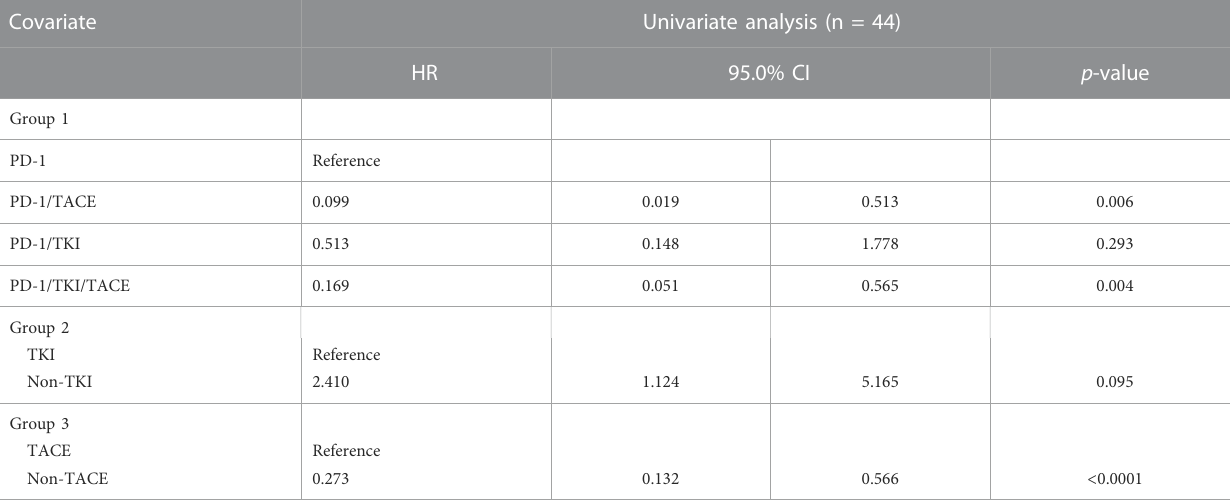
TABLE 4 Univariate analyses of irAEs ’ earliest occurrence time with Cox regression models.